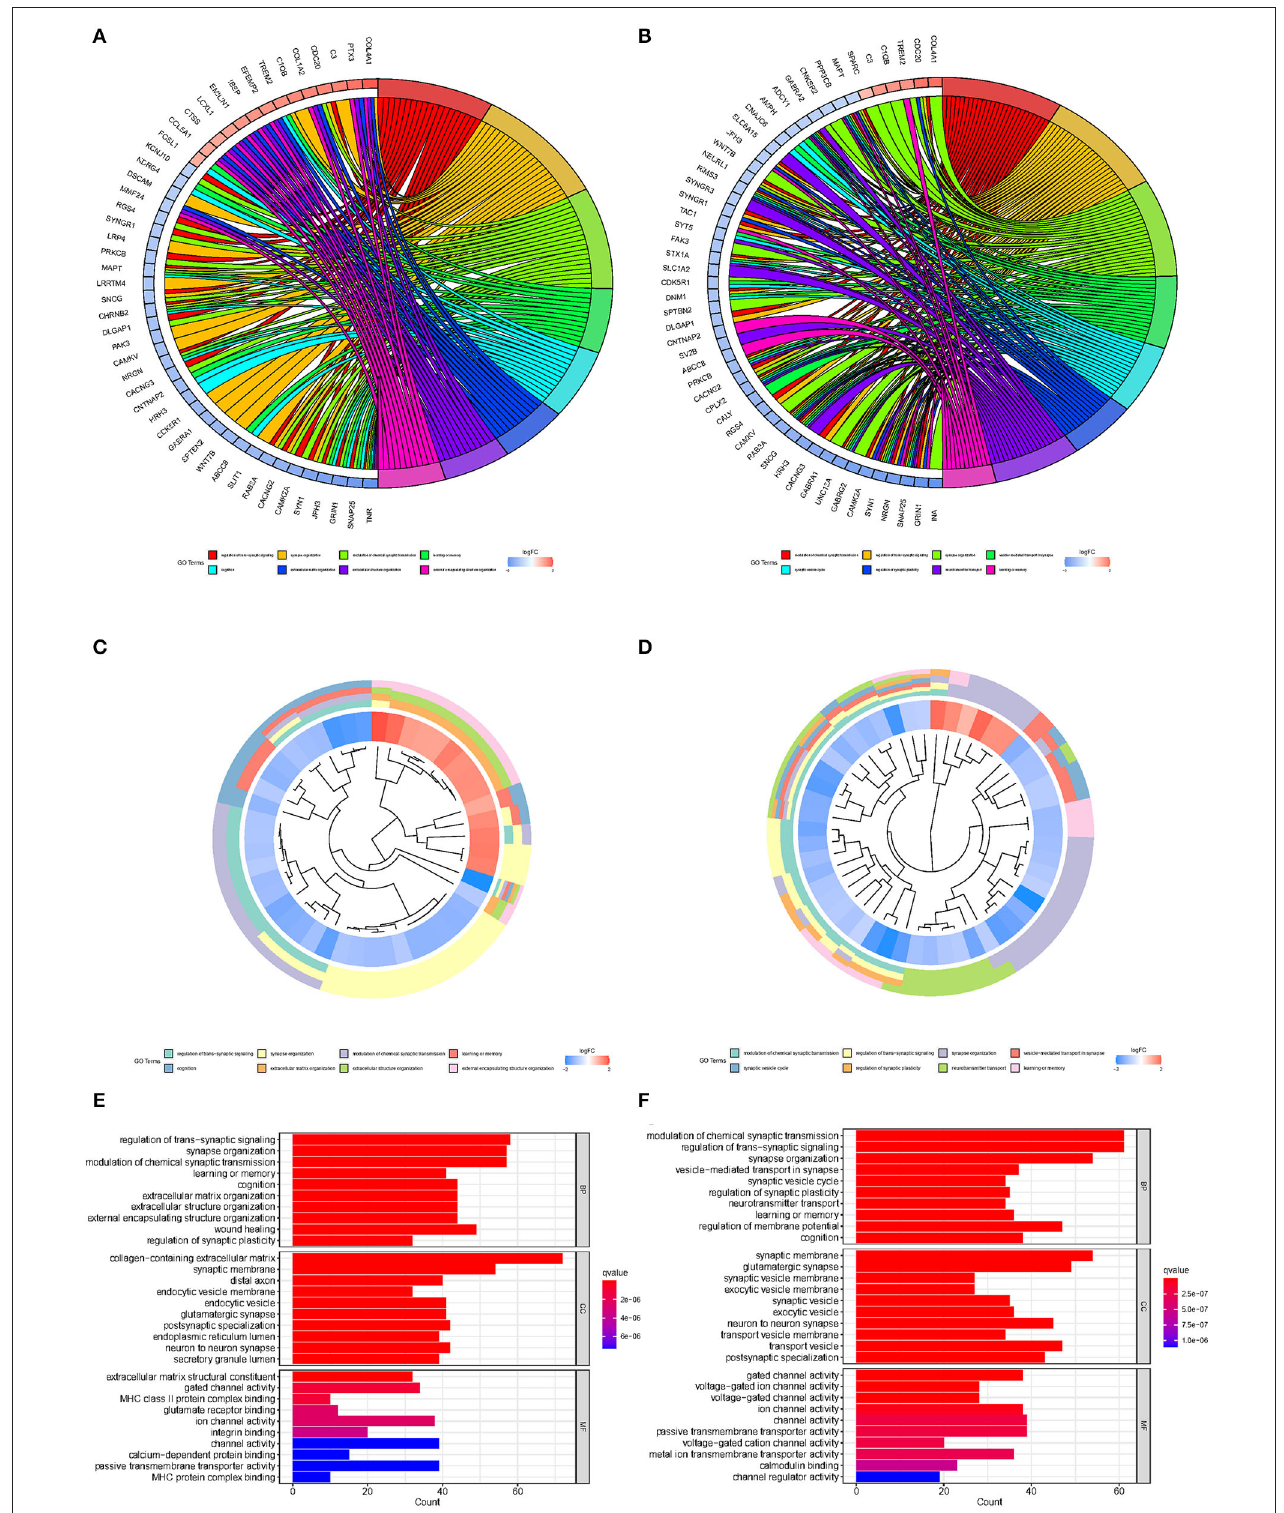
FIGURE 5 | Analyses of differentially expressed genes between two clusters using the Gene ontology (GO). (A, C, E) GO analysis for functional annotation of differentially expressed genes in two clusters of the TCGA database. (B, D, F) GO analysis for functional annotation of differentially expressed genes in two clusters of the GSE4412